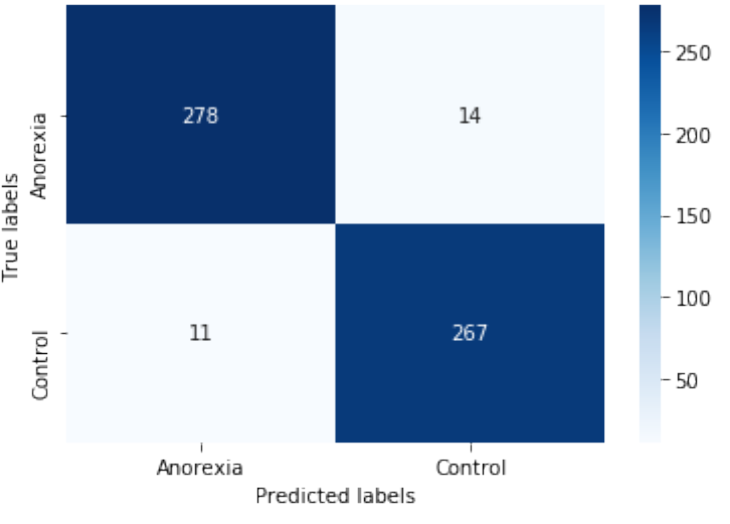
Figure 5. Confusion